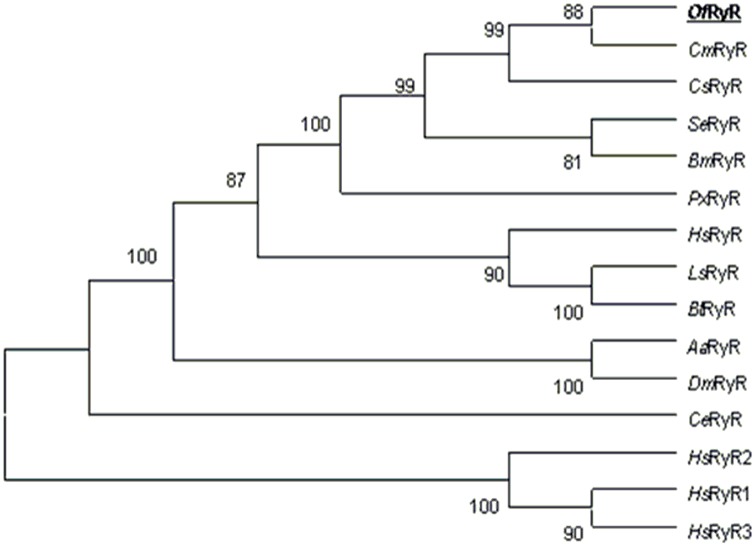
Phylogenetic tree of the RyR family.The Neighbor-joining tree was generated in MEGA5 with 1000 bootstrap replicates. The OfRyR amino acid sequence was aligned to 14 representative RyR isoforms and used for phylogenetic analysis. RyR sequences are obtained from GenBank: Cnaphalocrocis medinalis, AFI80904.1 (CmRyR); Chilo suppressalis, AFK84958.1 (CsRyR); Spodoptera exigua, AFC36359.1 (SeRyR); Plutella xylostella, AET09964.1 (PxRyR); Bombyx mori, DJ085056.1 (BmRyR); Harpegnathos saltator, EFN78897.1 (HsRyR); Laodelphax striatellus, AFK84959.1 (LsRyR); Bemisia tabaci, AFK84957.1 (BtRyR); Aedes aegypti, XP_001657320.1 (AaRyR); Drosophila mojavensis, XP_002005714.1 (DmRyR); Caenorhabditis elegans, BAA08309.1 (CeRyR); Homo sapiens RyR1, EAW56797.1 (HsRyR1); Homo sapiens RyR2, EAW70071.1 (HsRyR2); Homo sapiens RyR3, NP_001027.3 (HsRyR3).